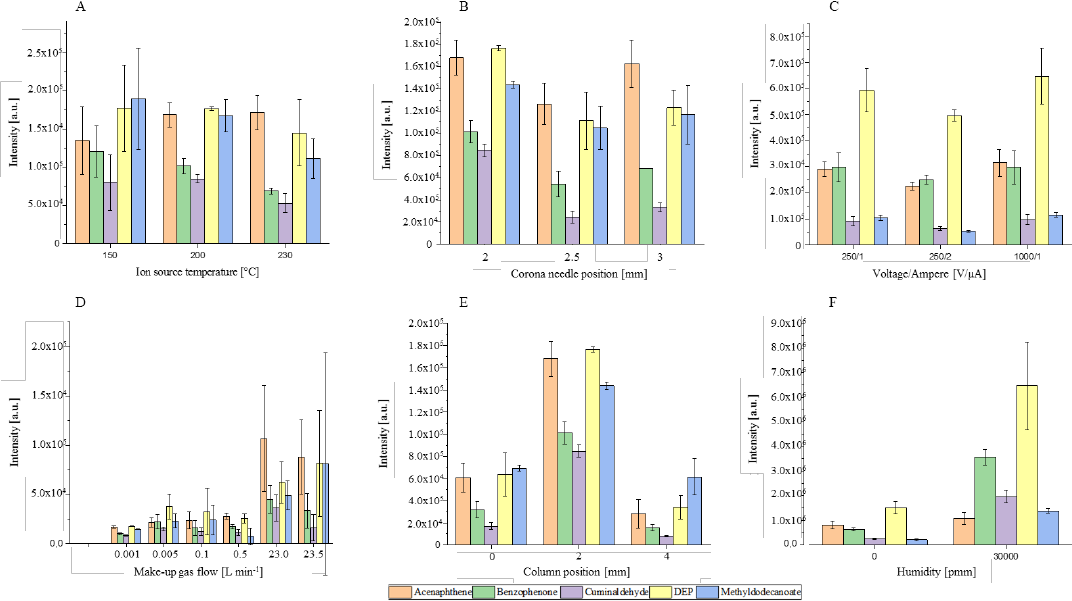
Figure 3. The influence of ion source parameters on the averaged ( n = 3) peak intensity (a.u.) of the [MH] + ions from acenaphthene (orange), benzophenone (green), cuminaldehyde (purple), diethylphthalate (DEP) (yellow), and methyldodecanoate (blue) as a function of ion source temperature ( A ), corona needle position ( B ), electrical field ( C ), make-up gas flow with high and low pressure region ( D ), column position ( E ), and humidity ( F ). Each parameter is changed separately from the starting method: needle height 2 mm, column position 2 mm, ion source temperature 200, electrical field 1000 V and 1 µA, humidity 0.1 ppm.